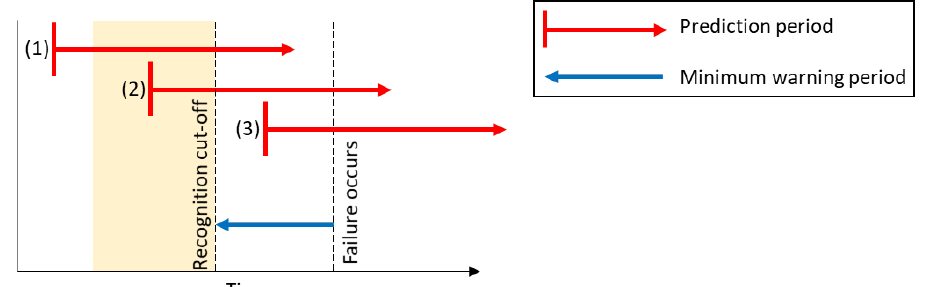
Figure 8. Illustration of online event prediction. After an event is predicted, an event is assumed to occur within the prediction period (red arrow). The prediction is valid if an event occurs within this period. The prediction should provide a minimum warning period (blue arrow) for plant operators to prepare for the event. Only warnings given in the gold shaded area will be both valid and provide plant operators with sufficient time to prepare for the event. (1) Invalid prediction as no fault occurs within the prediction period, (2) valid prediction, (3) invalid prediction as the minimum warning period is exceeded.